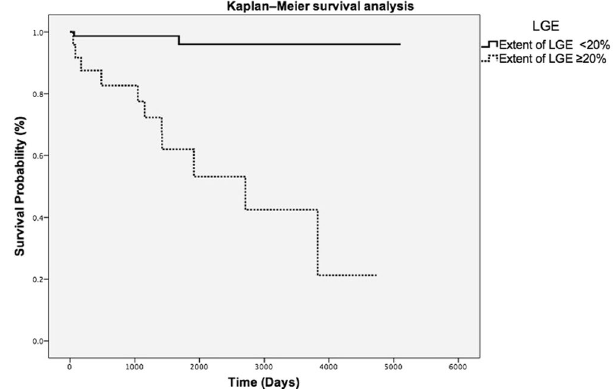
Figure 4. Kaplan-Meier event-free survival curves in patients with HCM according to extent of LGE%. According to this analysis, extent LGE ≥ 20% was an indicator of worse outcomes during follow-up compared with patients with extent LGE < 20% (Log-rank, p < 0.0001). HCM indicates hypertrophic cardiomyopathy; LGE, late gadolinium